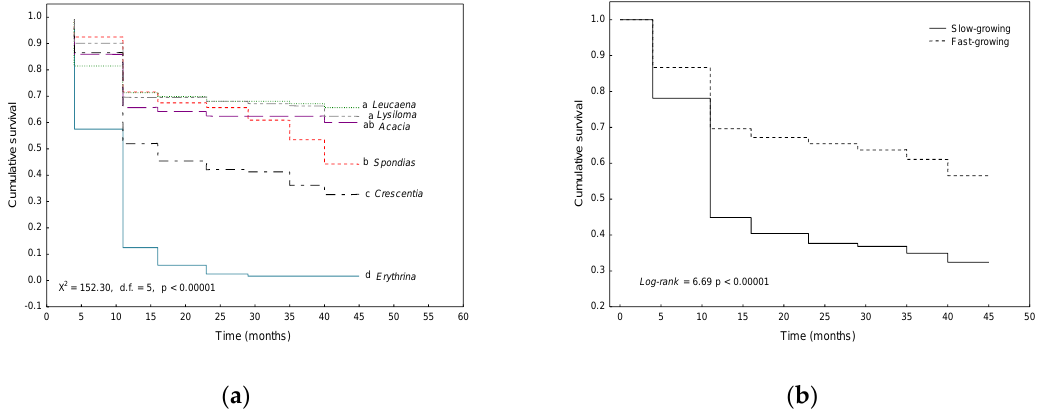
Figure 2. Kaplar–Meier curves of survival of (a) six tree species and (b) slow- and fast-growing species after 40 months growing in fenced plots at Quilamula, Morelos, Mexico. Species that do not share a letter showed significantly different survival under the log-rank comparison tests.